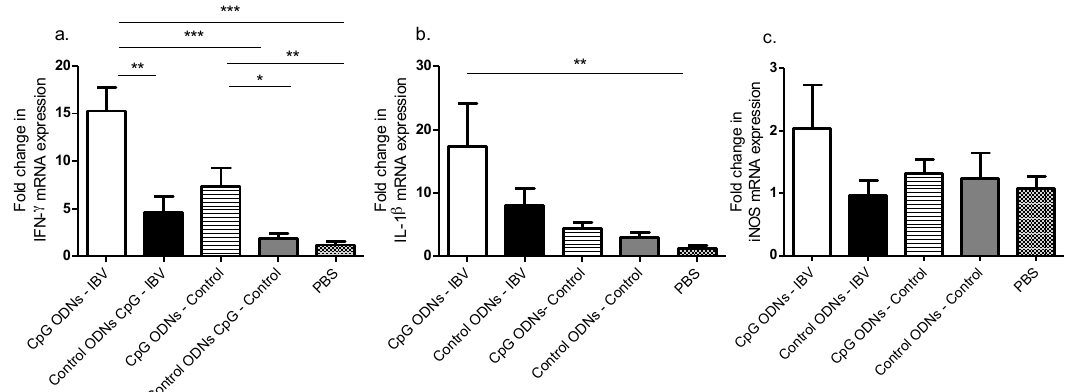
Figure 3. In ovo delivery of CpG ODNs is capable of inducing pro-inflammatory mediator mRNA expression levels in the lungs. ( a ) Fold change in the interferon (IFN)- γ mRNA expression, ( b ) fold change in the IL-1 β mRNA expression and c ) iNOS mRNA expression of 3 dpi lung. One-way ANOVA followed by Students-Newman-Keuls post hoc test was used to identify differences in mRNA expression levels. The differences were considered significant at * = significant at p ≤ 0.05, ** = significant at p ≤ 0.01 *** = significant at p ≤ 0.001. The results represent pooled data of two independent